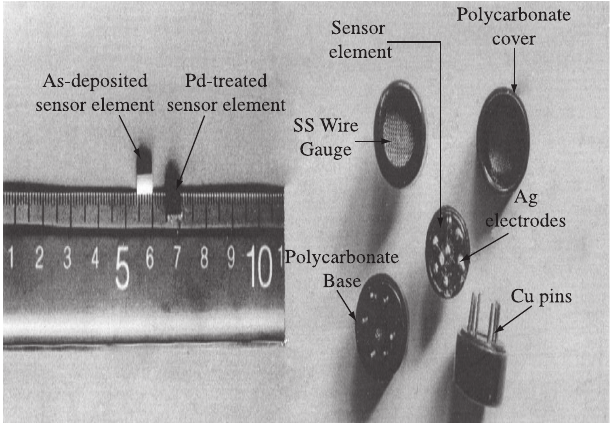
Figure 1. As-deposited and Pd-treated sensor element on glass tube and sensor assembly housed inside a polycarbonate casing.